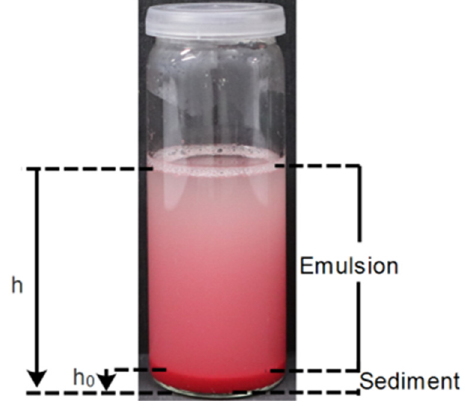
Figure 1. Visual explanation of the h and h 0 used for Equation 1.